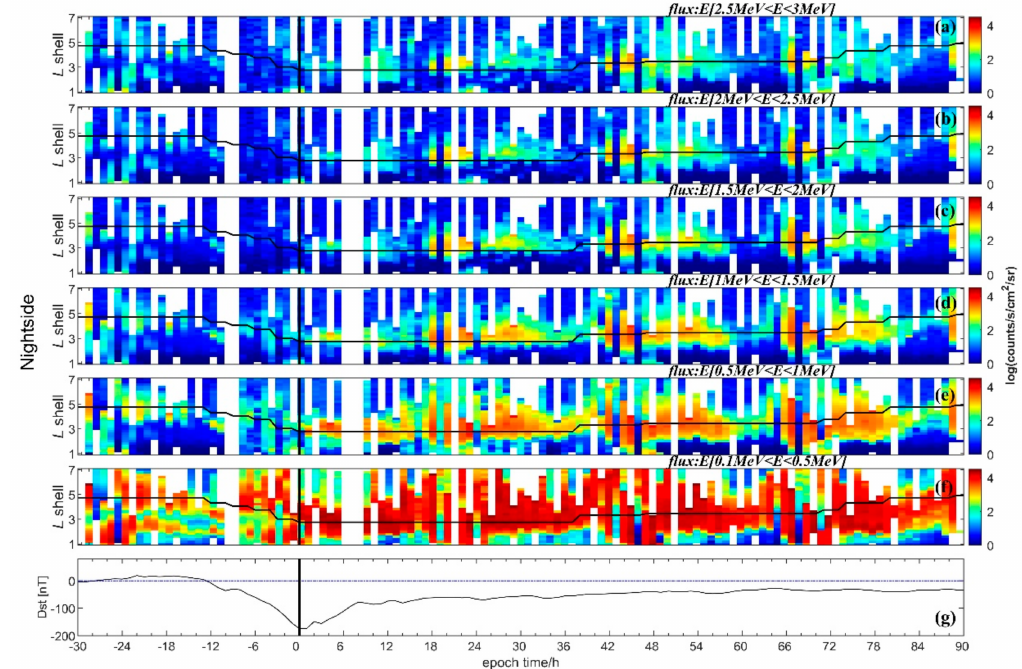
Figure 7. Same as Figure 6 but for the nightside